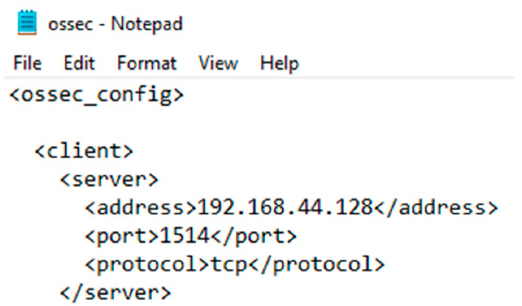
Figure 7. Server IP con fi guration fi le.